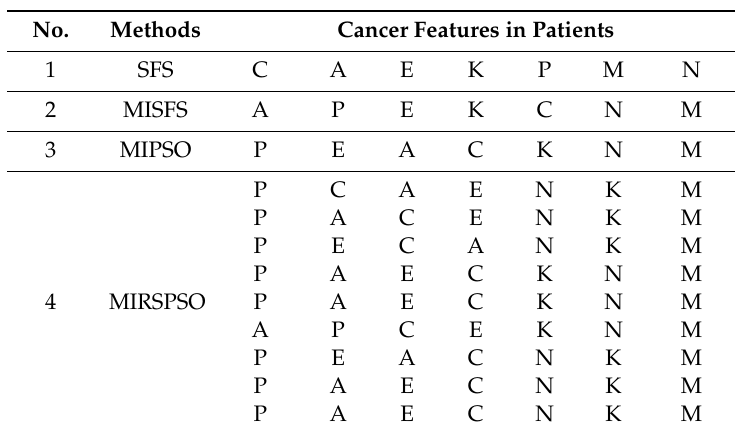
Table 2. Importance ranking of cancer features in patients by di ff erent methods.